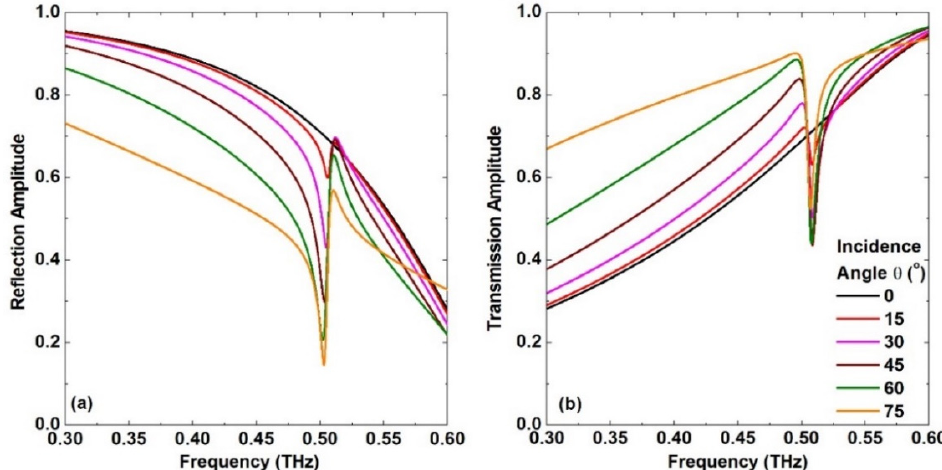
Figure 2. ( a ) Reflection and ( b ) transmission frequency response of the symmetric complementary split rectangular resonators for a sweep of incidence angle ( θ ) between 0° and 75° with a step of 15°.